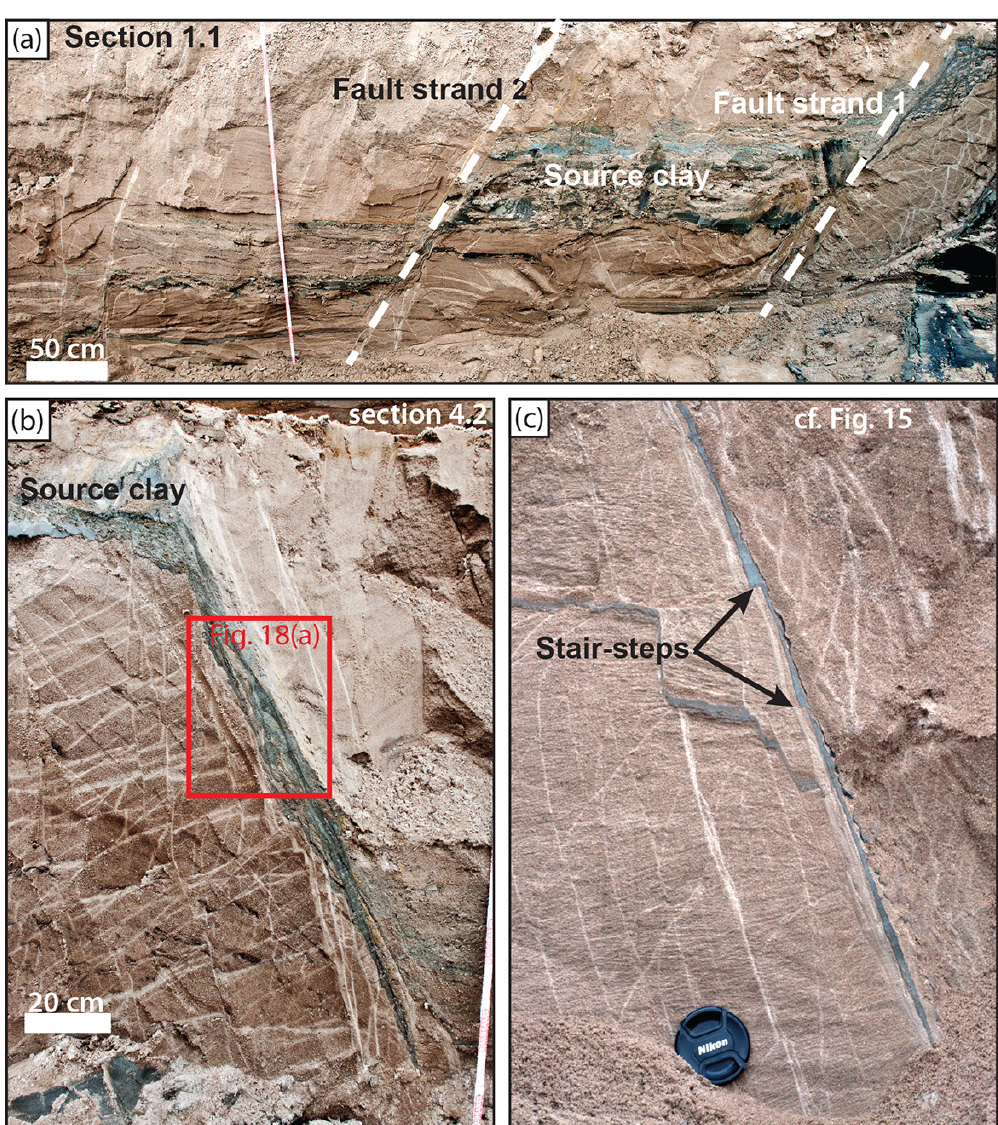
Figure 8. Vertical sections 1.1 (a) and 4.2. (b) . (c) vertical section 5. This section was excavated during a different field campaign, but at the same fault and elevation at the talus next to the excavation